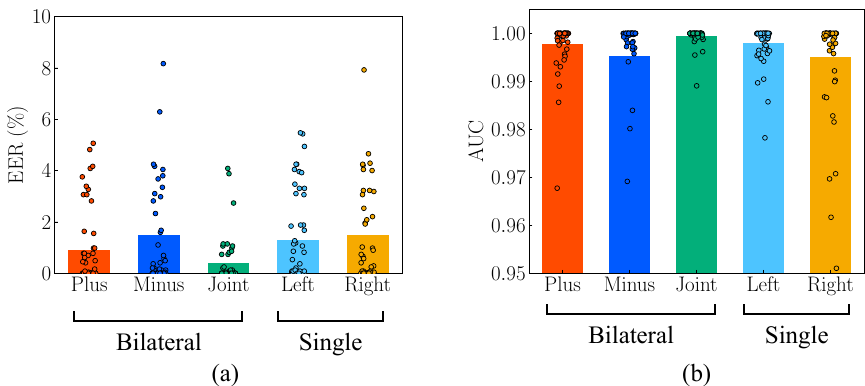
Figure 9. Authentication accuracy for bilateral ear acoustic authentication (Plus, Minus, and Joint) and single-ear acoustic authentication (Left and Right). ( a ) EER. ( b )